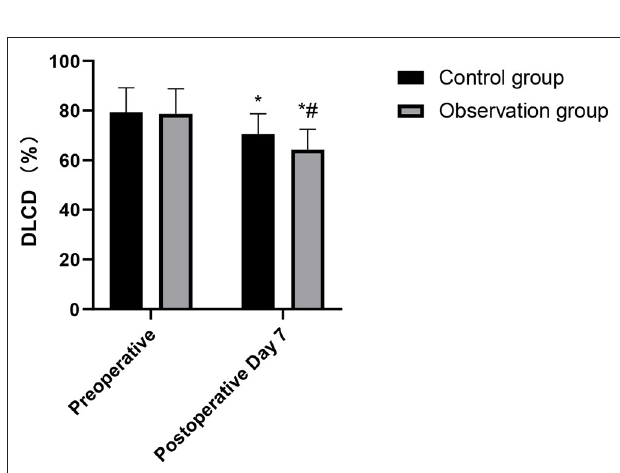
FIGURE 6 | Comparison of DLCD changes in the patients of the two groups. Compared with preoperative, * p < 0.05. Compared with the control group, # p < 0.05.